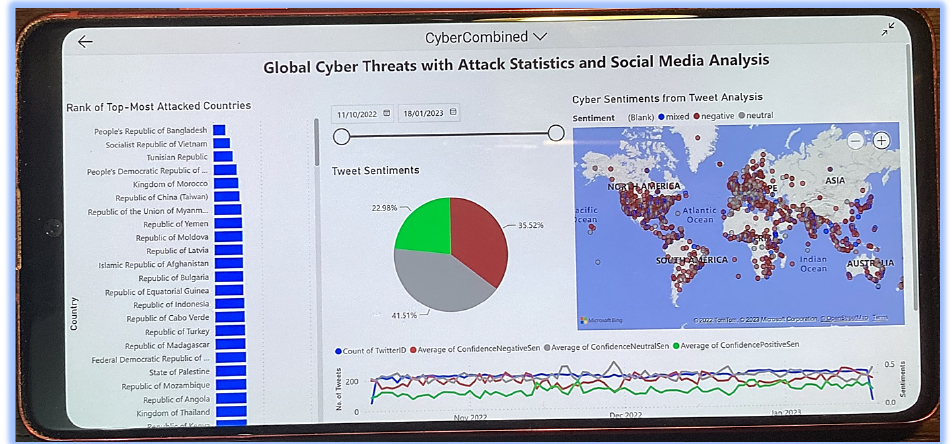
Figure 4. Social media-based cyber threat dashboard executed on a Samsung Galaxy Note 10 Lite Mobile (Android Device).